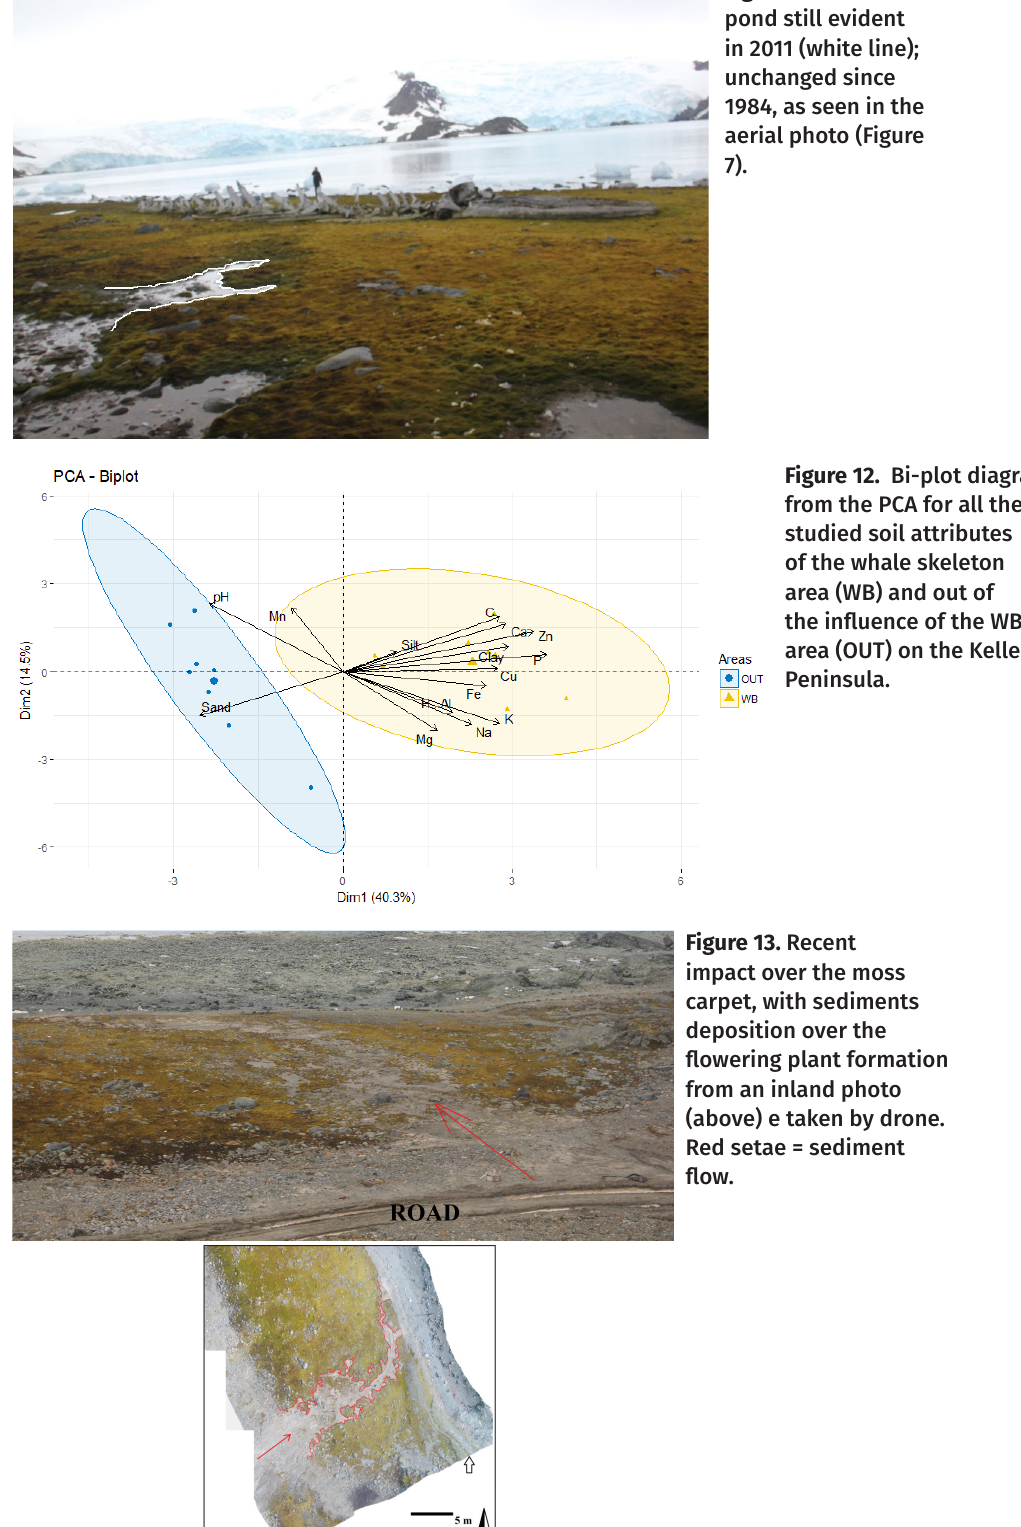
Figure 13. Recent impact over the moss carpet, with sediments deposition over the flowering plant formation from an inland photo (above) e taken by drone. Red setae = sediment flow.